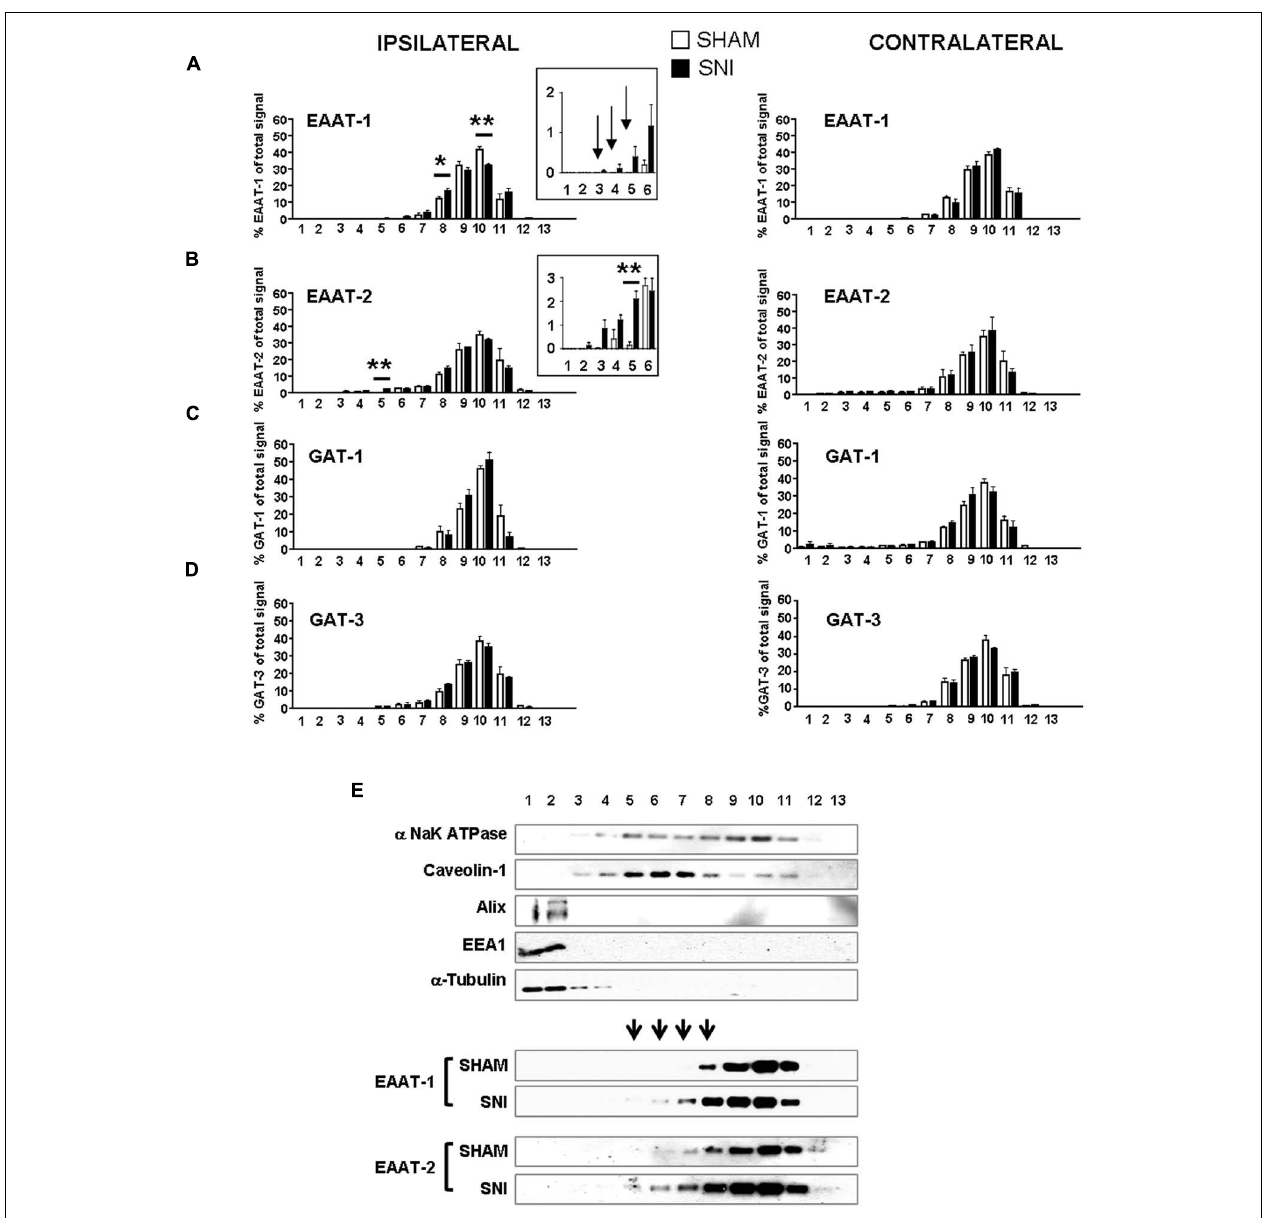
condition). Arrows in (A) indicate signal detected in SNI samples with no counterparts in sham fractions. (E) Representative immunoblots of subcellular fractionation illustrating the shift of EAAT-1 and EAAT-2 content in SNI spinal cord, in the caveolin-1 enriched fractions. Arrowheads indicate fractions that are sites or EAAT-1 increase in SNI